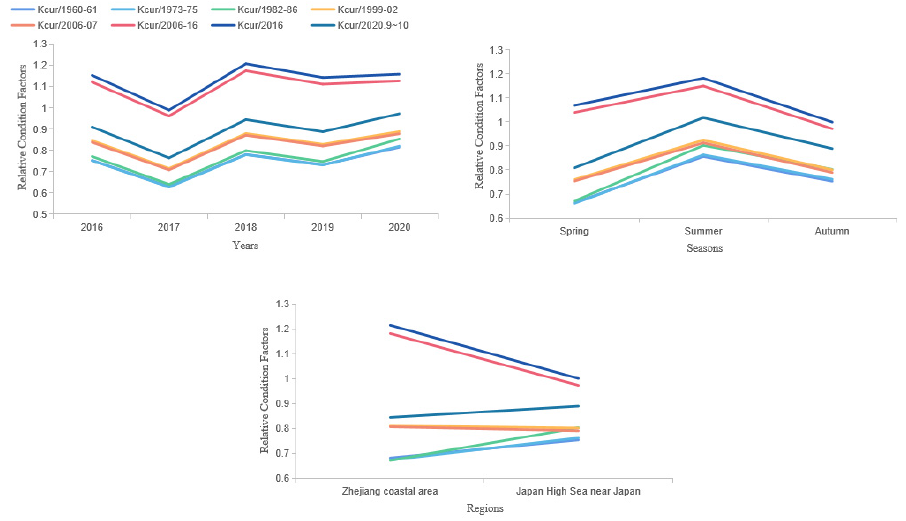
Figure 6. Changes in condition factors for Chub mackerel by years, seasons, and regions.